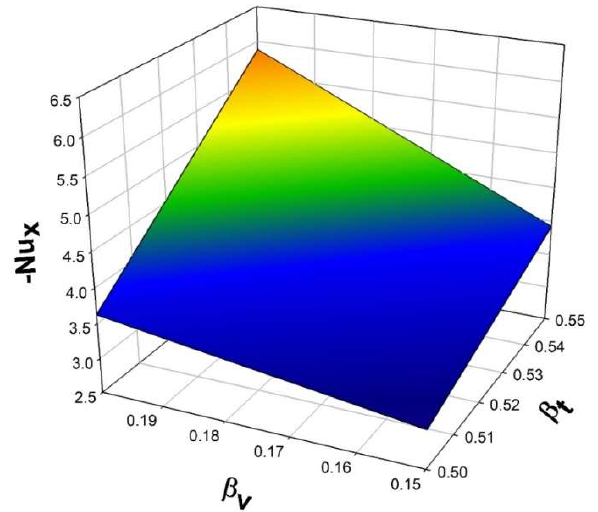
Figure 8. Three-dimensional representation of Nu x with the impact of the interaction parameters for velocity and temperature.